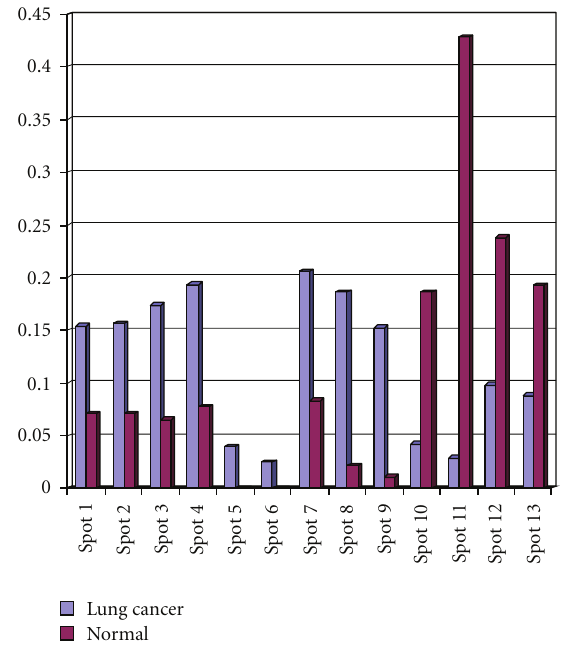
Figure 5: Comparison of content in 13 di ff erent expressed protein spots before and after lung cancer formation. The content of protein spots in plasma of lung cancer increased obviously in nos. 1, 2, 3, 4, 7, 8, 9 spots (more than twice) and decreased in nos. 10–13 spots (more than twice), and nos. 5-6 were the new protein spots.